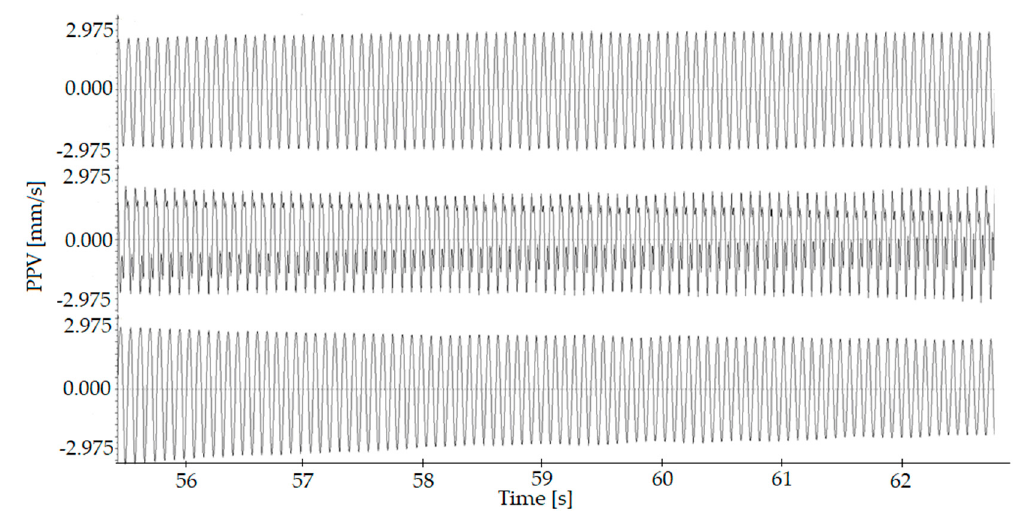
Figure 8. Example of a wave pattern record of sheet piles.